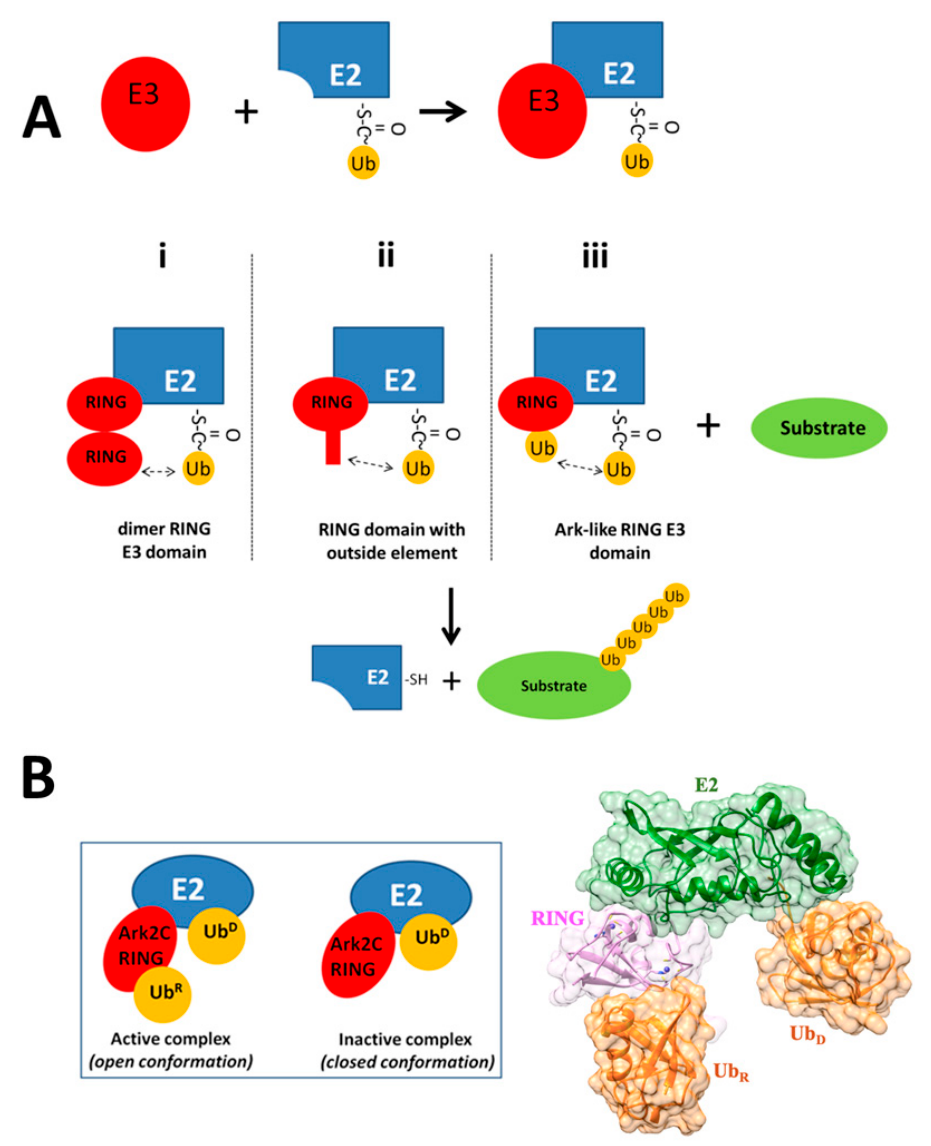
Figure 1. ( A ) Stabilization of the closed conformation of the E2-Ub thioester conjugation enzyme by E3 RING ligases. In the schematic interaction, E2 is shown to interact with: ( i ) Canonical dimeric E3 RING domain (e.g., cIAP2, RNF4), ( ii ) RING ligases with an additional N -terminal component (e.g., RNF38), ( iii ) Monomeric E3 RING ligases of the Arkadia type (e.g., RNF165). Arrows with dashed line signifies interactions favoring the activation of Ub for transfer to substrates (“closed conformation” or “E2~Ub”); ( B ) Active and inactive complexes (left panel) and 3D structure of active complex (right panel) of Ark2C with E2 enzyme and Ub.